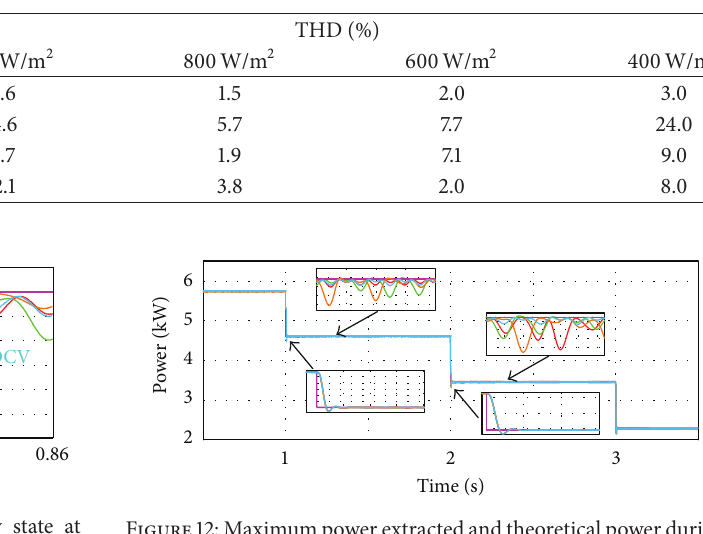
Table 1: Efficiency of the different MPPT.